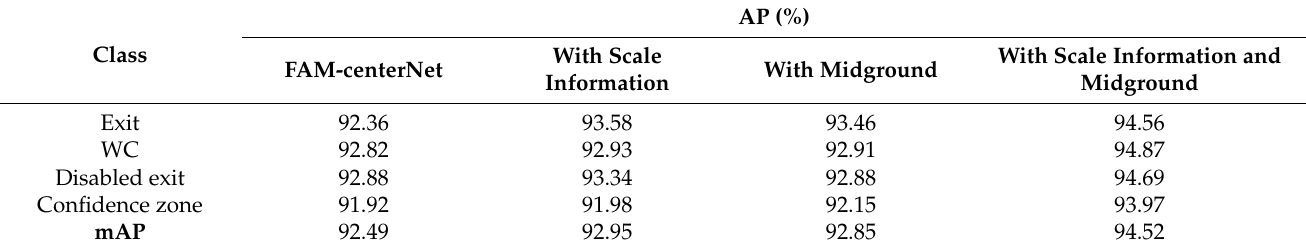
Table 4. Ablation study on the impact of the scale information and midground